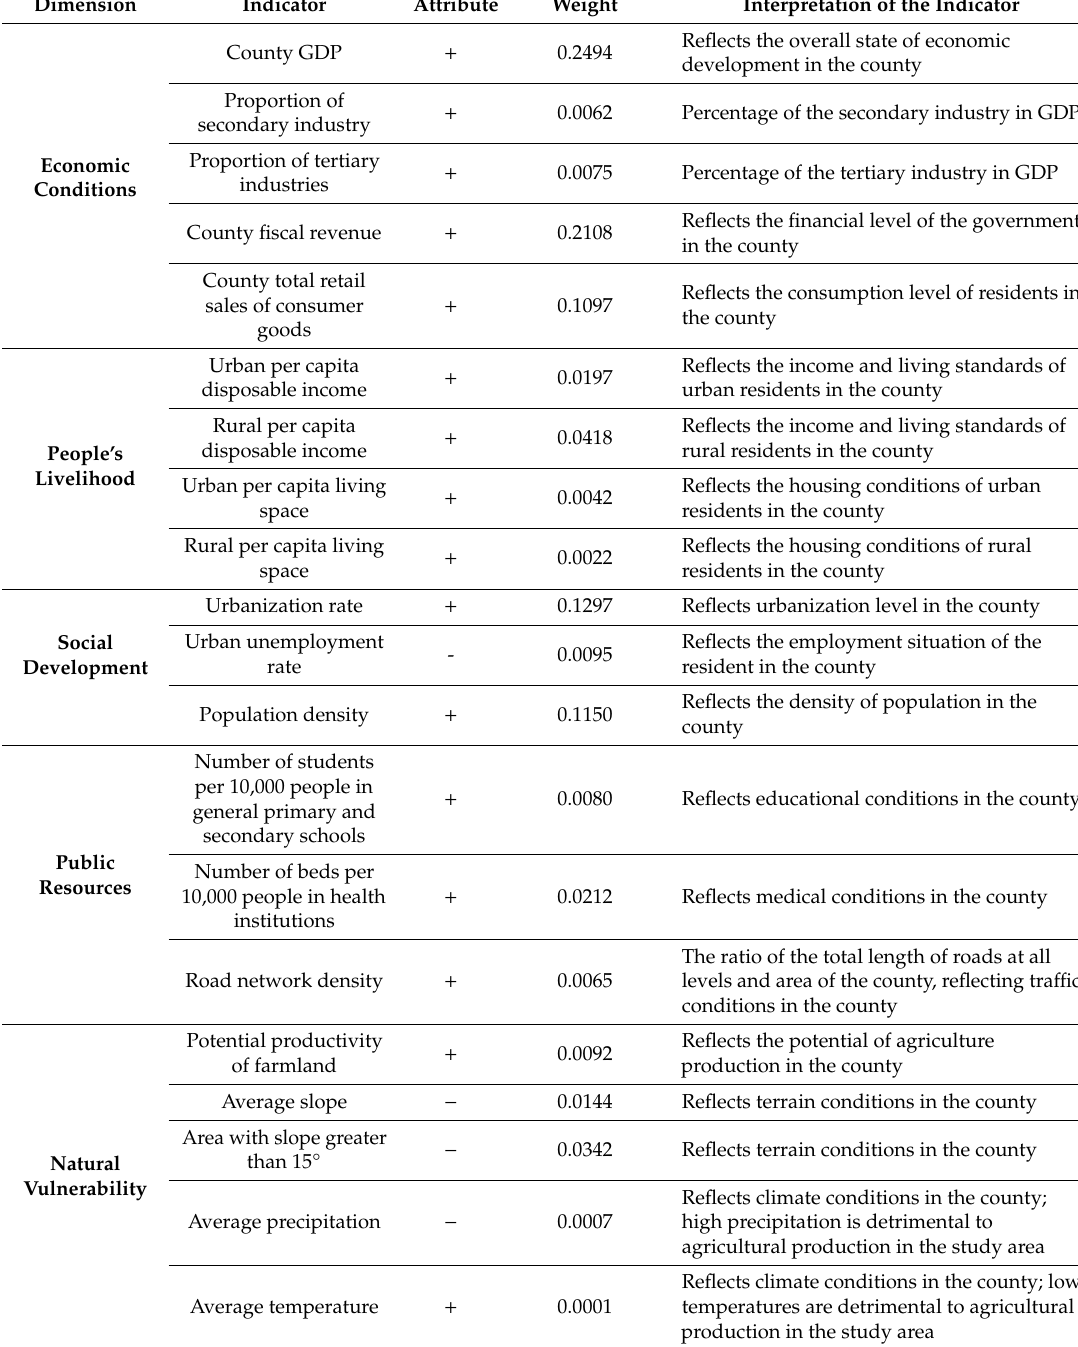
Table 2. Evaluation indicators used to calculate the County-level Economic Index